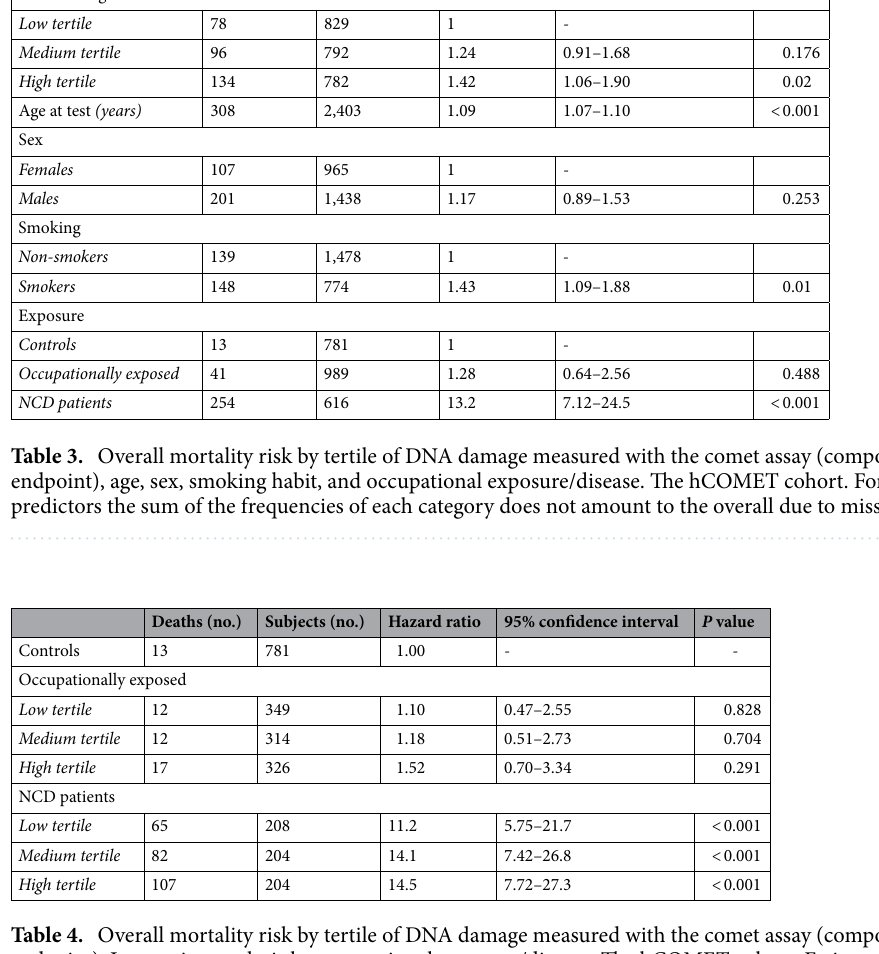
Table 4. Overall mortality risk by tertile of DNA damage measured with the comet assay (composite endpoint). Interaction analysis by occupational exposure/disease. The hCOMET cohort. Estimates adjusted for age, sex, smoking habit. For some predictors the sum of the frequencies of each categories does not amount to the overall due to missing